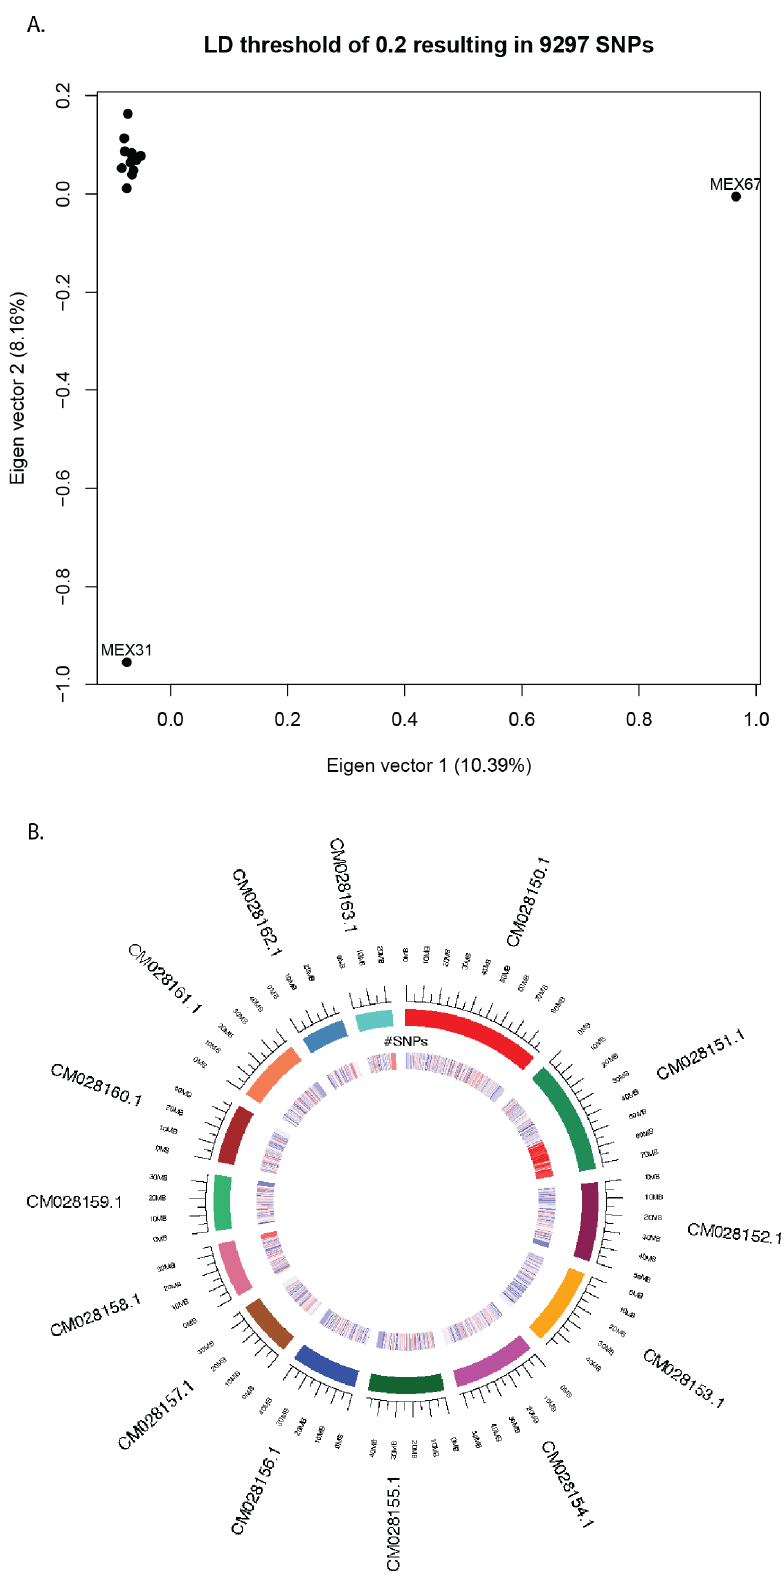
Figure 7. SNP analyses using linkage disequilibrium thresholds set to 0.2 resulting in 9297 SNP markers: ( A ) Principal component analysis (PCA) and ( B ) SNP density along 500 Kb sliding window on 14 chromosomes (colored). Regions of SNP density are illustrated on a color gradient from blue ( low ) to red ( high